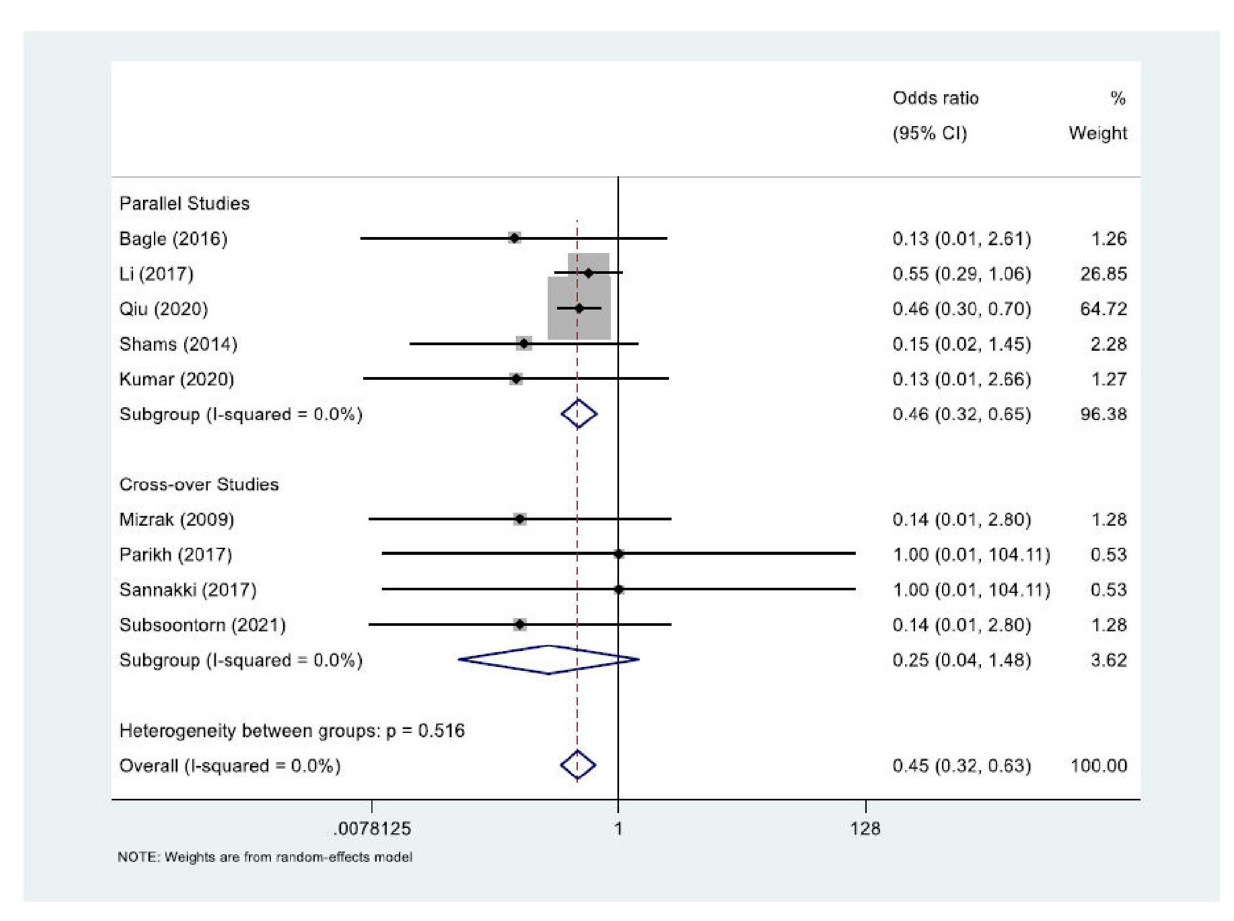
FIGURE2 Forest plot of all studies that investigated dexmedetomidine (vs, placebo) in the treatment of PIA.